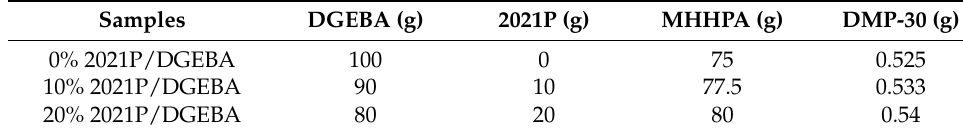
Table 1. Addition proportion of components in different blends.